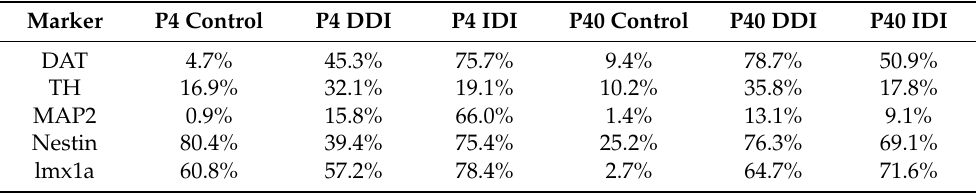
Table 2. Flow Cytometry analysis following the DDI and IDI.